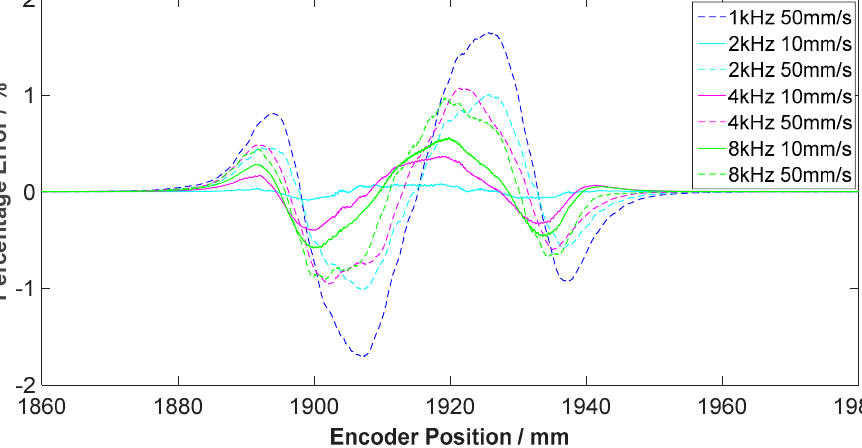
Figure 11. Percentage error plot obtained by applying interpolation on the 1 kHz 10 mm/s trajectory before delay compensation. As the group delay is a function of the output data rate (decimation rate D), the greatest delay was registered at the 1 kHz 50 mm/s case. Table 9. Percentage errors comparison before and after delay compensation was